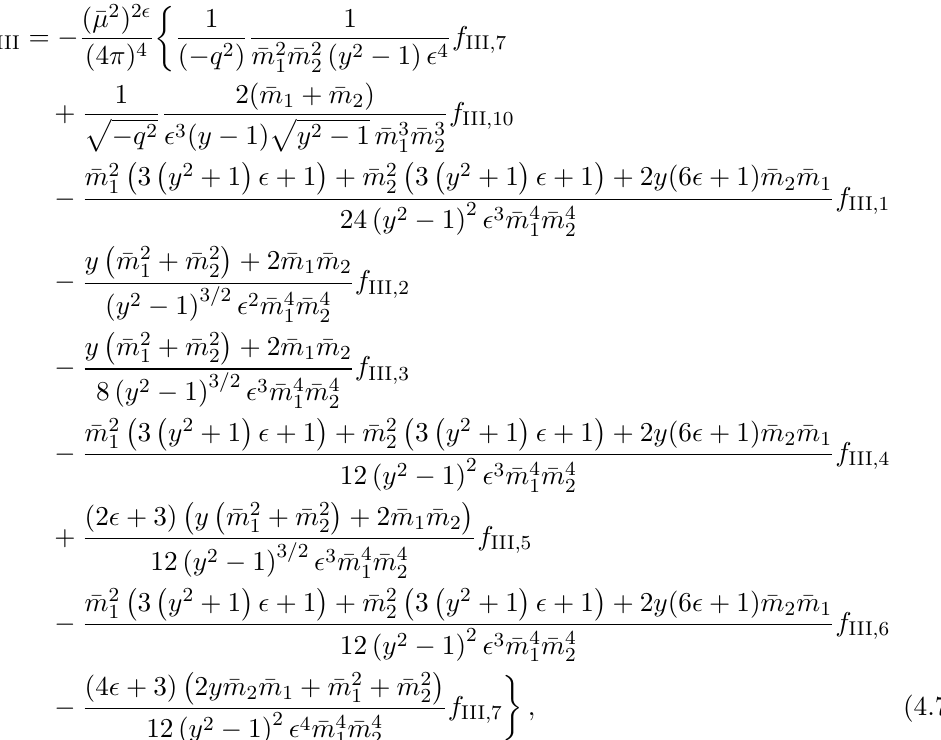
q topologies relevant for the double-box master j j